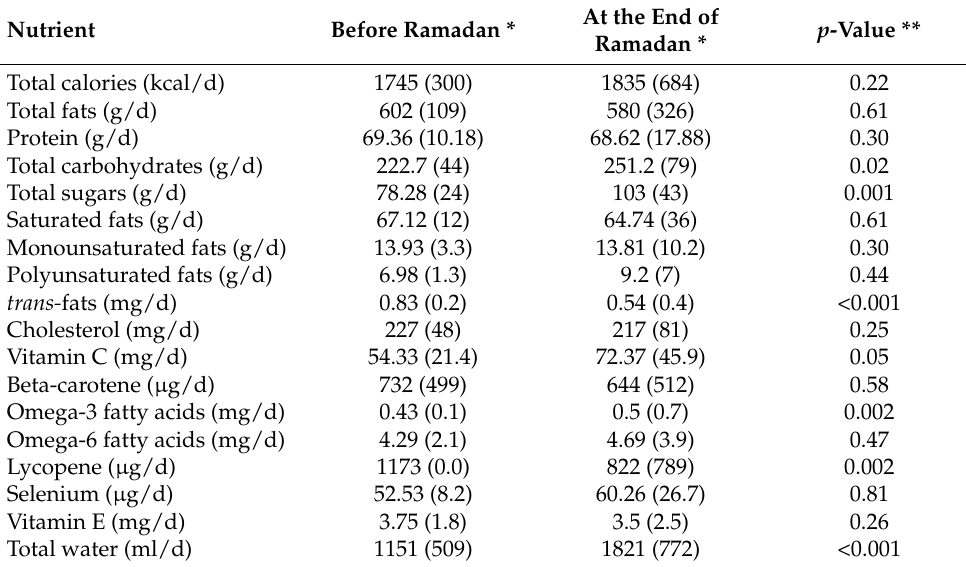
At the End of Ramadan *